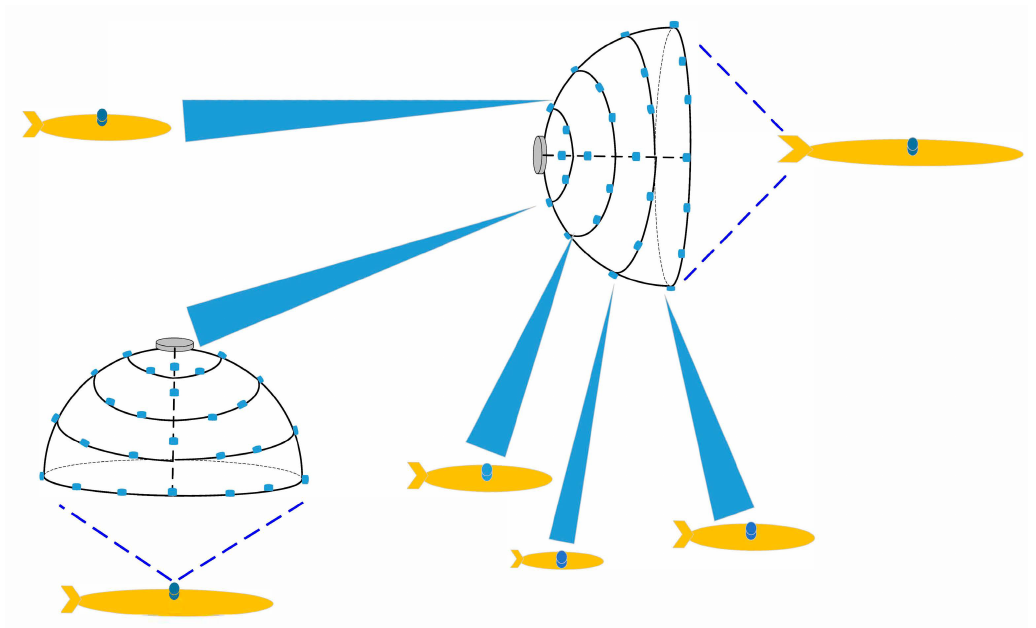
Figure 1. Underwater optical communication network based on the hemispherical LED